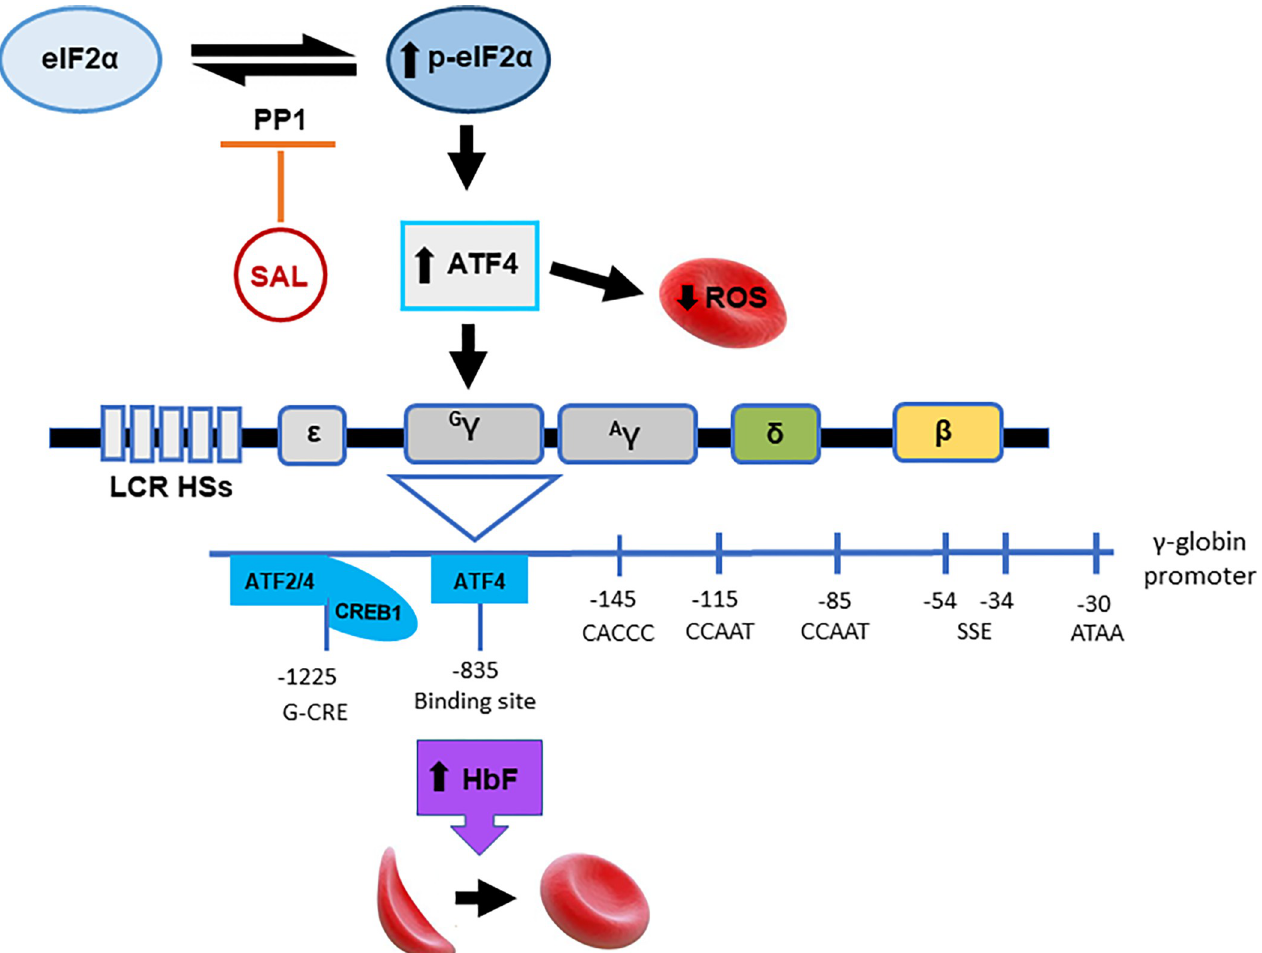
S1 Table. Summary of primer sequences. S1 Fig. SAL increased γ -globin transcription and HbF synthesis in K562 cells at